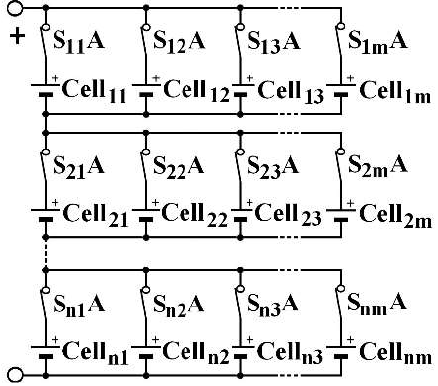
Figure 2. SP (series-parallel) architecture.